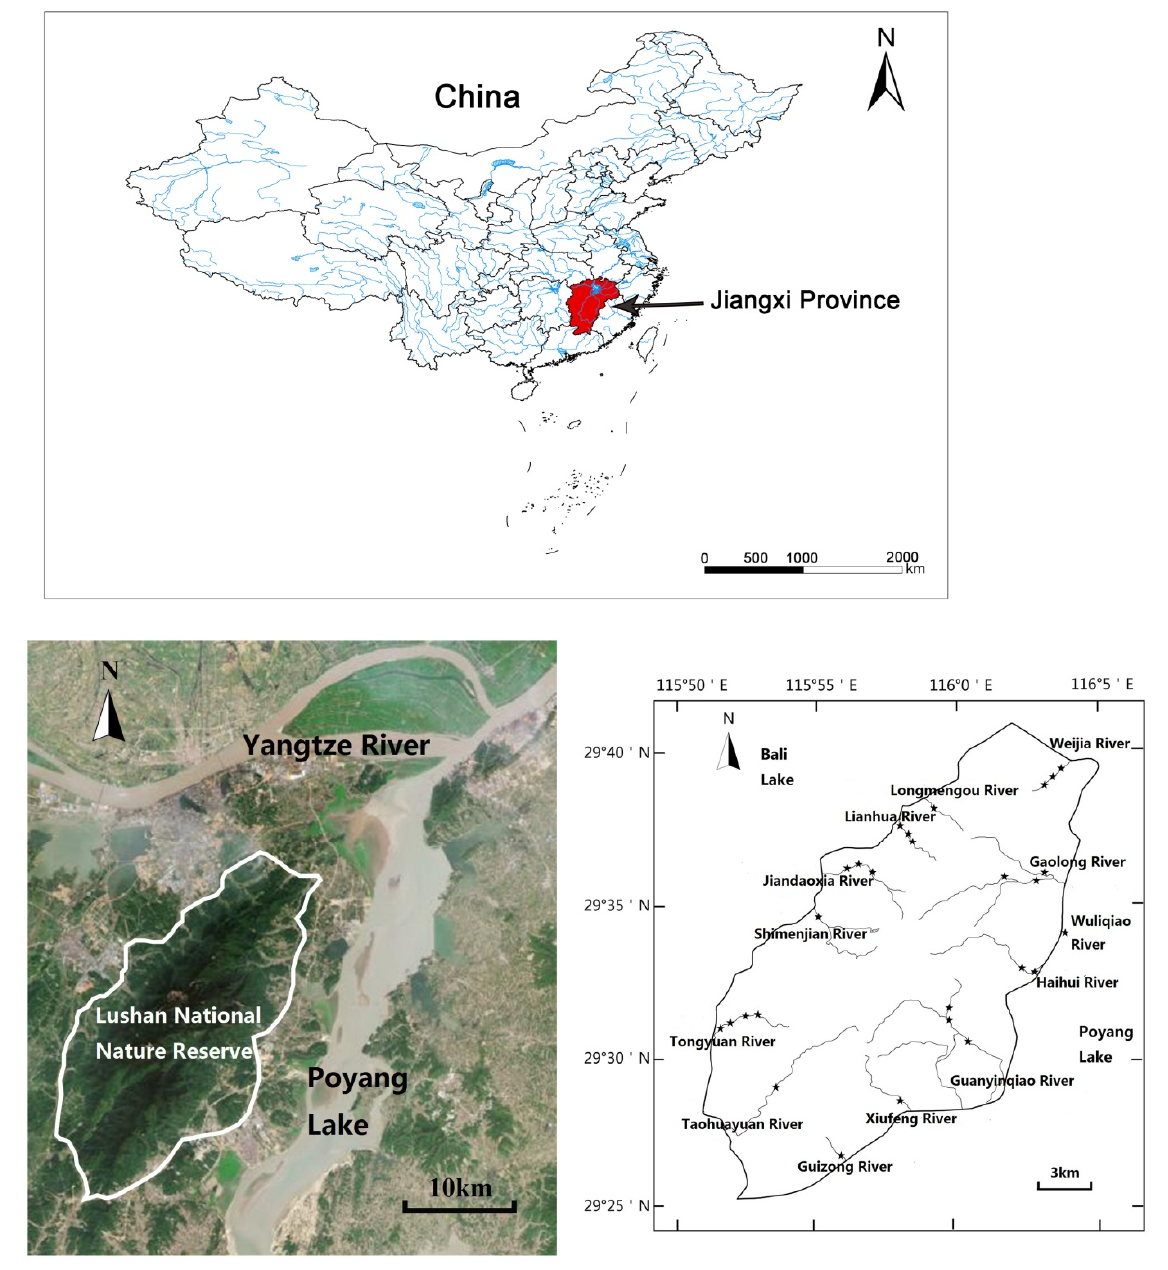
Figure 1. Map showing the study area of the Lushan National Nature Reserve. Black stars represent the sampling sites.